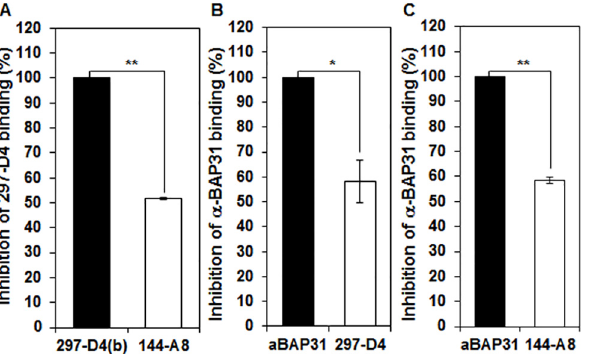
Fig 4. Antibody-antibody competition binding assay. (A) hESCs were preincubated with biotinylated 297-D4 in the presence of isotype control antibody and 144-A8 prior to the addition of phycoerythrin- conjugated streptavidin. (B,C) hESCs were preincubated with α -BAP31 in the presence of isotype control antibody, 297-D4 (B), 144-A8 (C) prior to the addition of FITC-conjugated anti-rabbit IgG. Antibody binding to hESCs was then analyzed by flow cytometry. The percent of binding inhibition was calculated from mean fluorescence intensity. Statistical analysis used the Student ’ s t-test ( * p < 0.05; ** p <